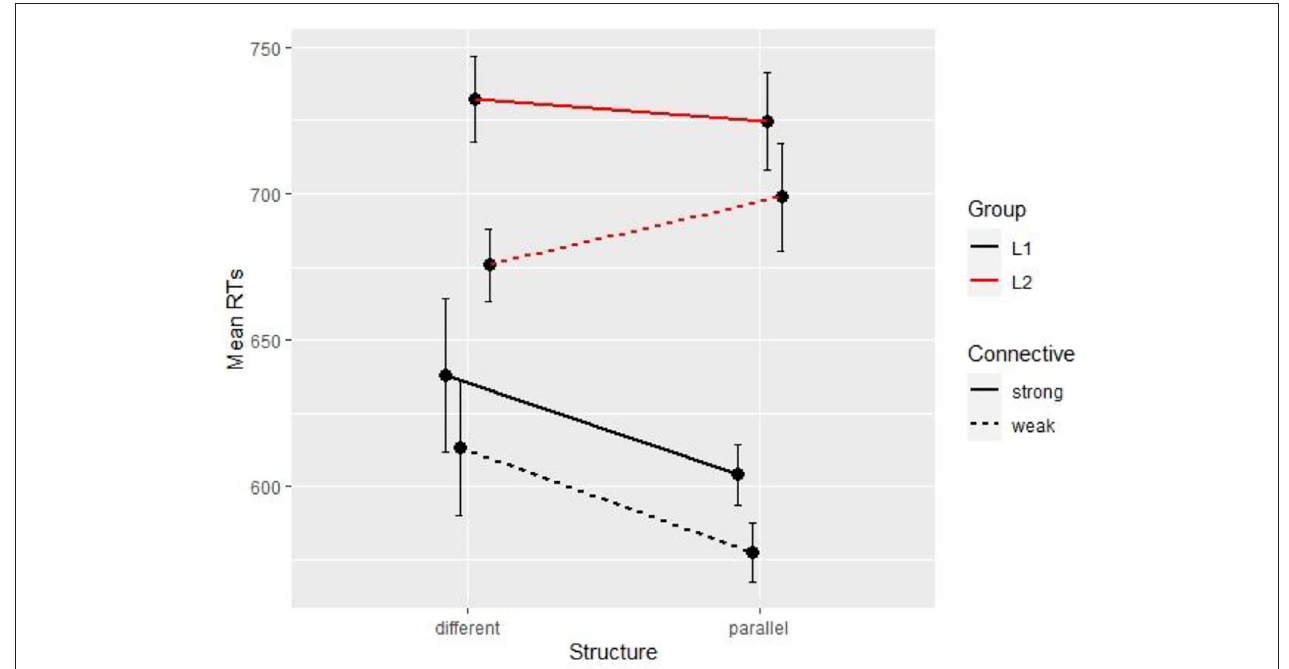
FIGURE 4 | Mean reading times per condition and per group (Experiment 3, Segment 4).